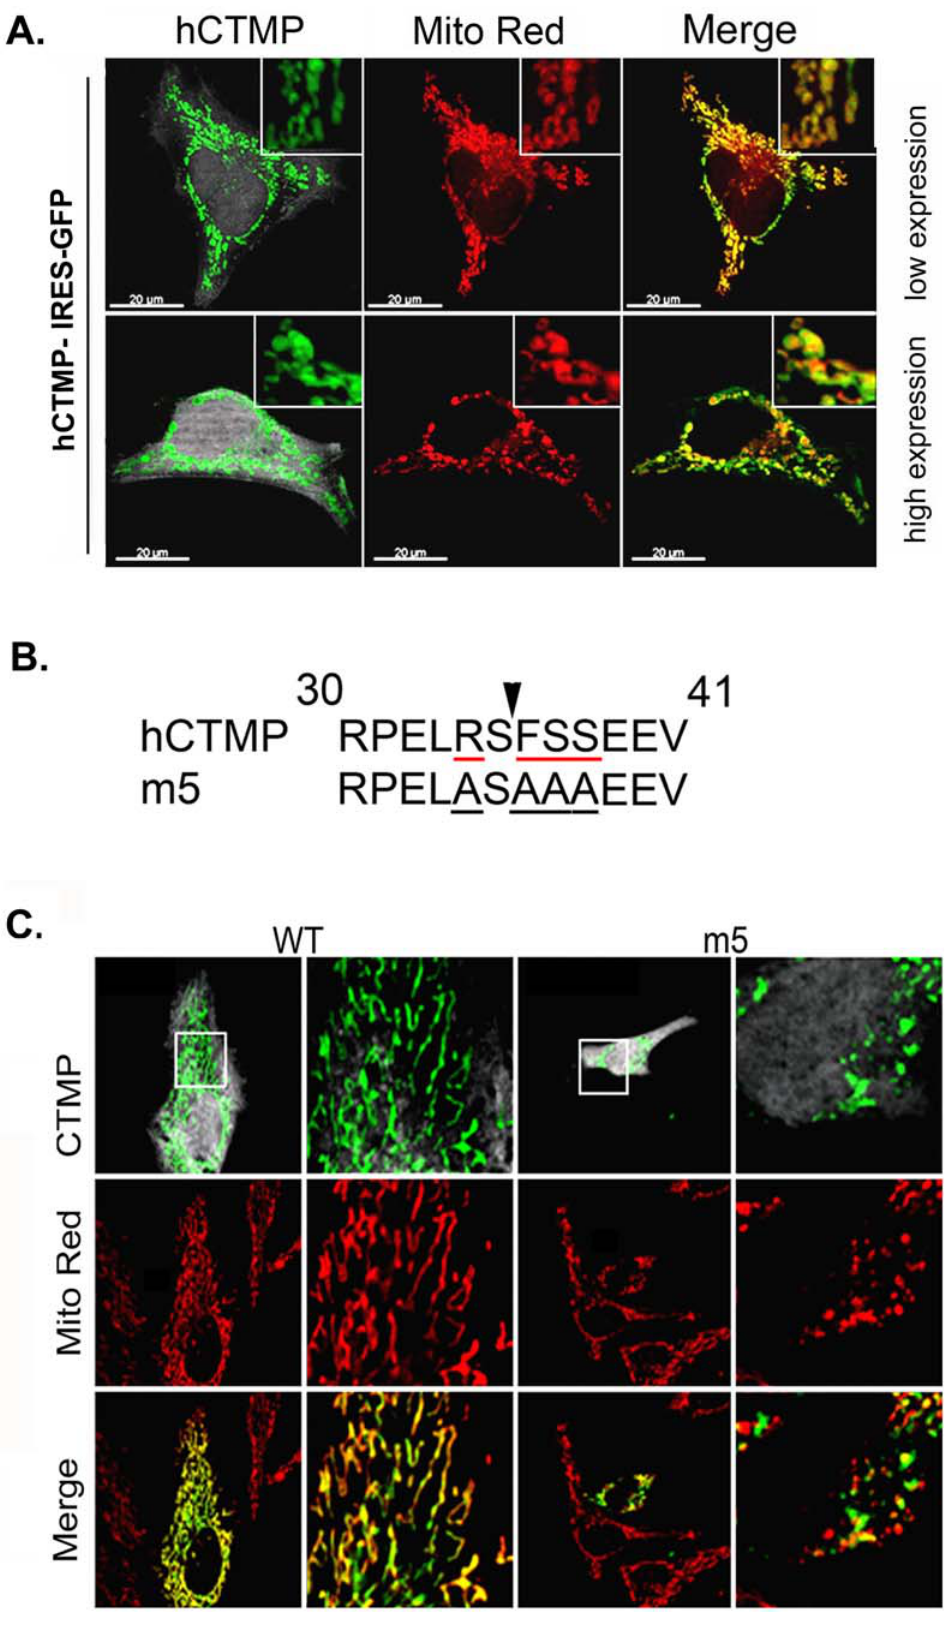
Figure 1. Interfering with CTMP maturation leads to swollen mitochondria. (A) Full length human CTMP tagged with GFP was transfected into HeLa cells at low (upper panels) or high (lower panels) levels of expression. Mitochondria were visualized with Mitotracker Red. Merged fluorescence indicates CTMP-GFP expression in mitochondria. The round appearance of mitochondria is visible in cells with high levels of CTMP